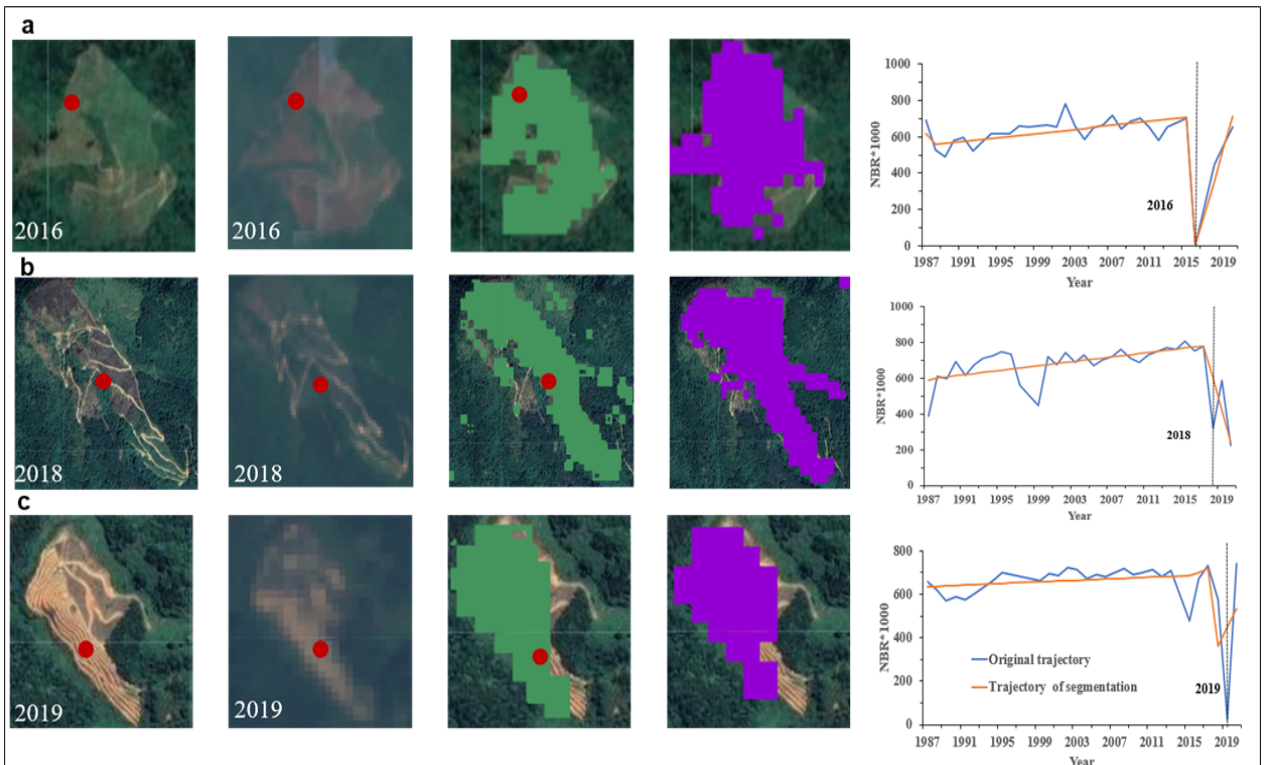
Figure 4. The comparisons of detected forest loss area with the GFC product at selected disturbance areas in ( a ) Ningming County, ( b ) Yongfu County, and ( c ) Rong County in Guangxi Province. Note: the red dots are the sampling plots, which are also the points for fitting the disturbance trajectories; the first column is the Google HD images; the second column is the Landsat true color composite images; the third column is the detected forest loss area in this study; the fourth column is the GFC forest loss area. The fifth column is the LandTrendr fitted disturbance trajectories based on NBR alone.